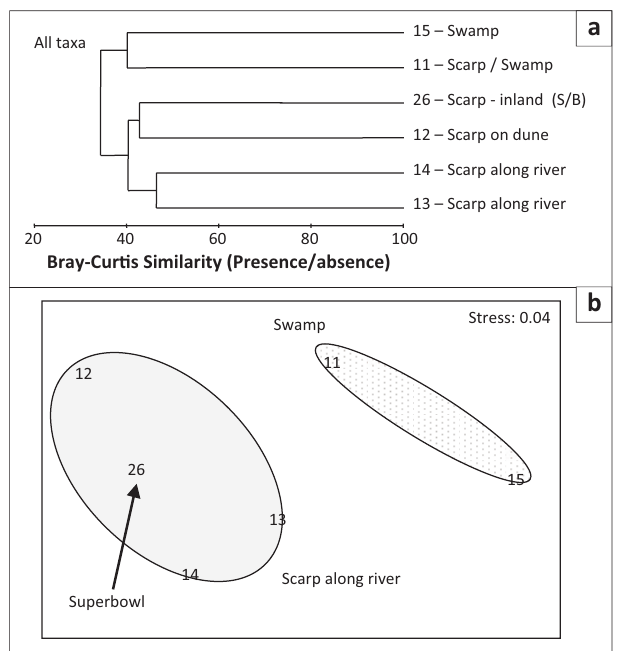
FIGURE 6: Community relationships among forest sites at Mkambati for all taxa. (a) Similarity analysis and (b) multi-dimensional scaling